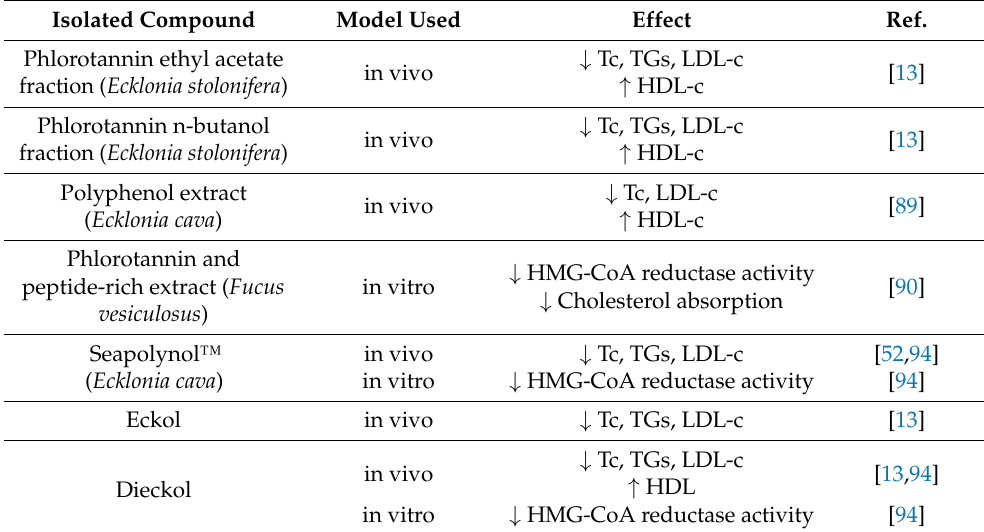
Table 4. Overview of the in vitro and/or in vivo hypocholesterolemic effect of phlorotannins isolated from different brown algae species under different extractions conditions. Isolated Compound Model Used Effect